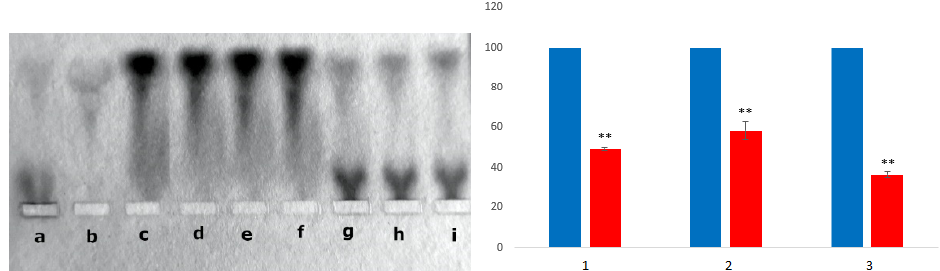
Figure 7. ( a ) HAI, ( b ) BSA, ( c ) BSA-CR, ( d – f ) BSA-CR-RhoB (1:1), (2:1), and (5:1) respectively, ( g – i ) BSA-CR-RhoB (1:1), (2:1), and (5:1) respectively after adding the same amount of HAI. The data in the graphs compare controls (blues bars) with results (red bars) and represent the mean ± SEM; test Student T. ** p <